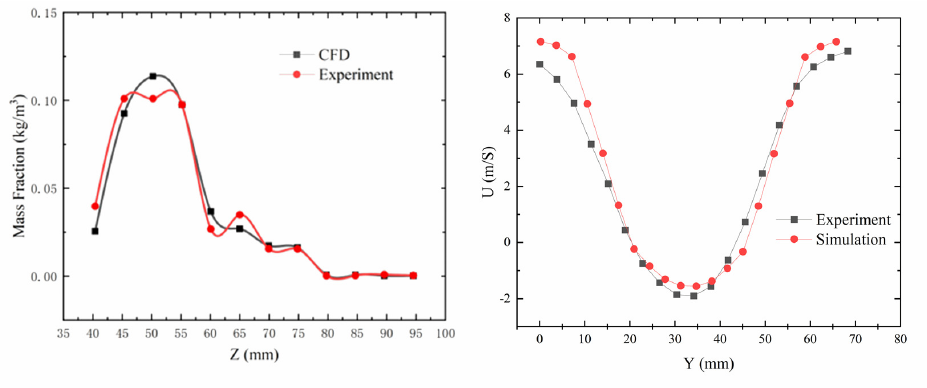
Figure 4. Comparison between numerical simulation results and experimental results.